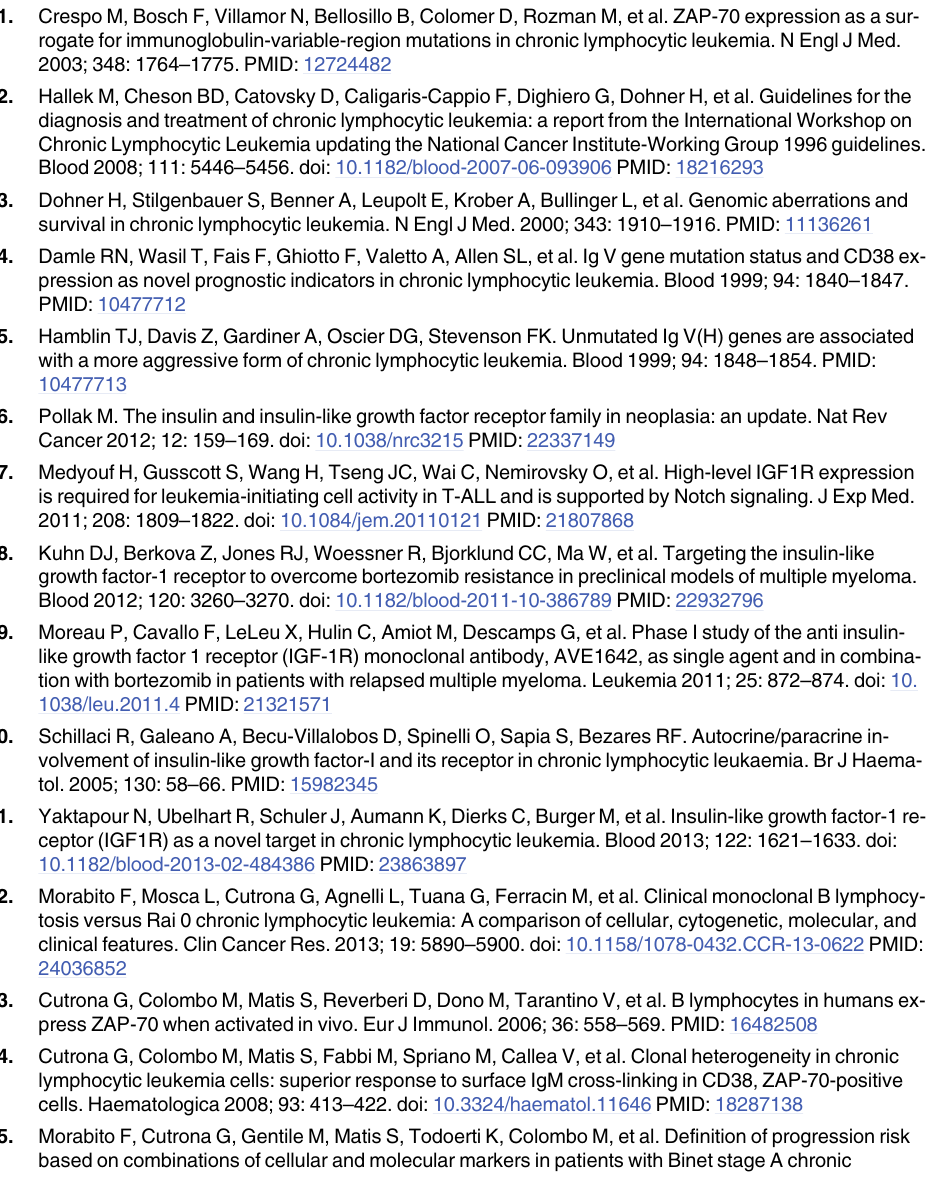
S1 Table. Most common stereotyped subsets prevalence and corresponging IGF1R expres- sion